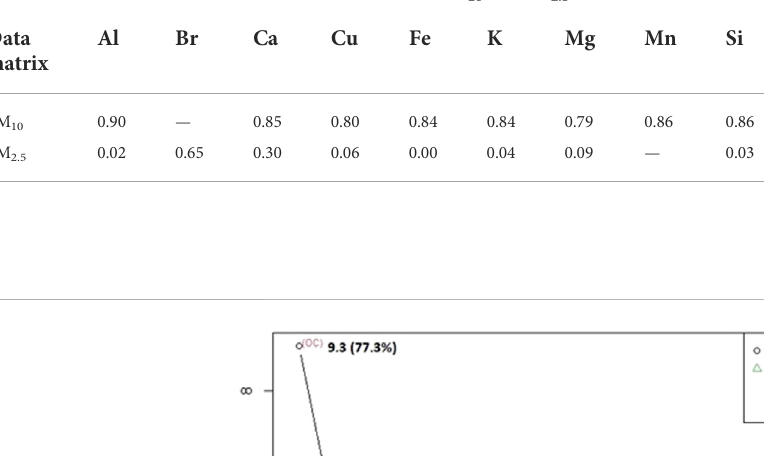
TABLE 2 Calculated MSA criteria values for variables in PM 10 and PM 2.5 data matrices.